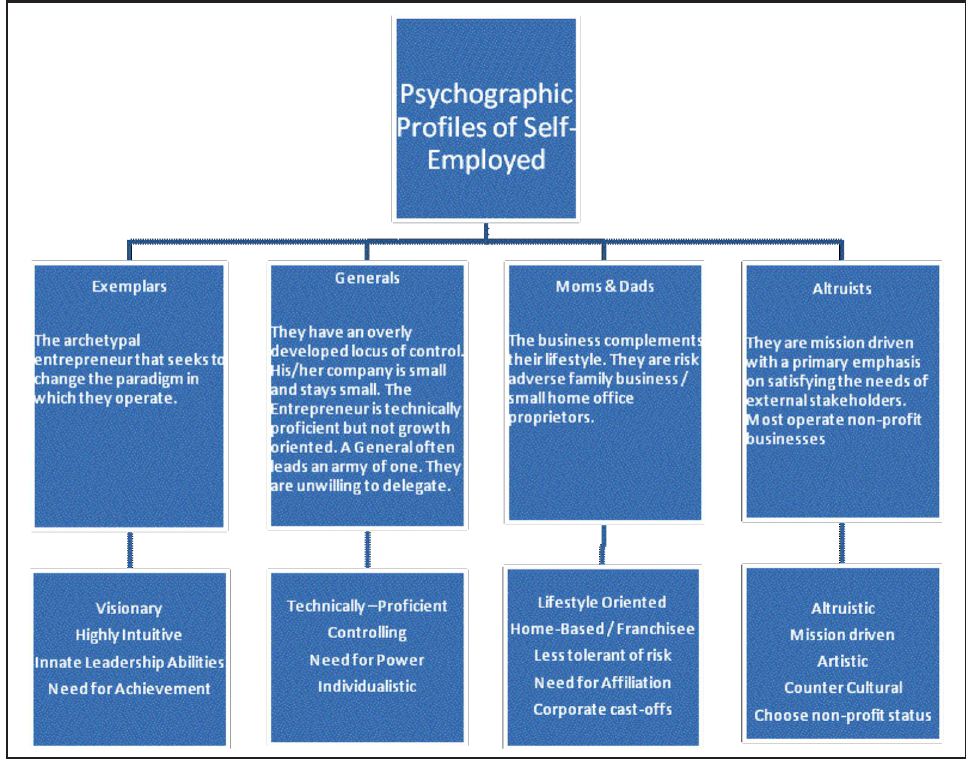
Figure 3: Psychographic self-employed